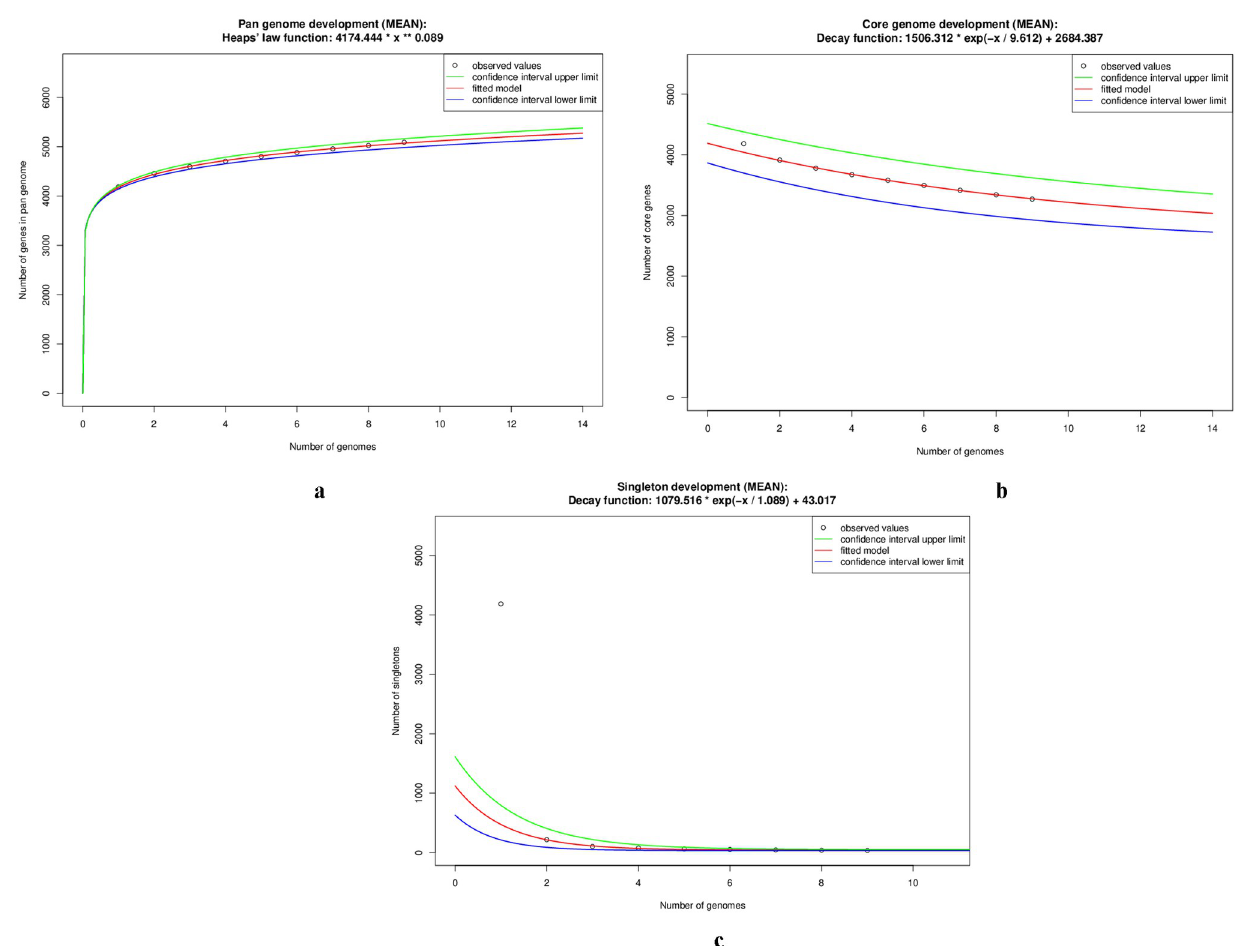
Fig 2. Core genome development plot for nine Salmonella genomes. The red curve shows the fitted model. Green represents confidence interval upper limit and blue demonstrates confidence interval lower limit.